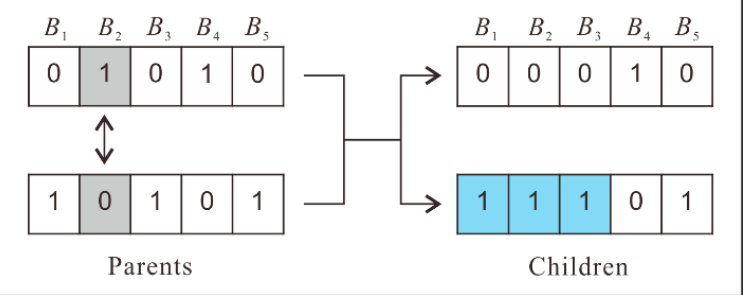
Figure 8. Example of generic uniform crossover (conflicting genes are shown in blue).